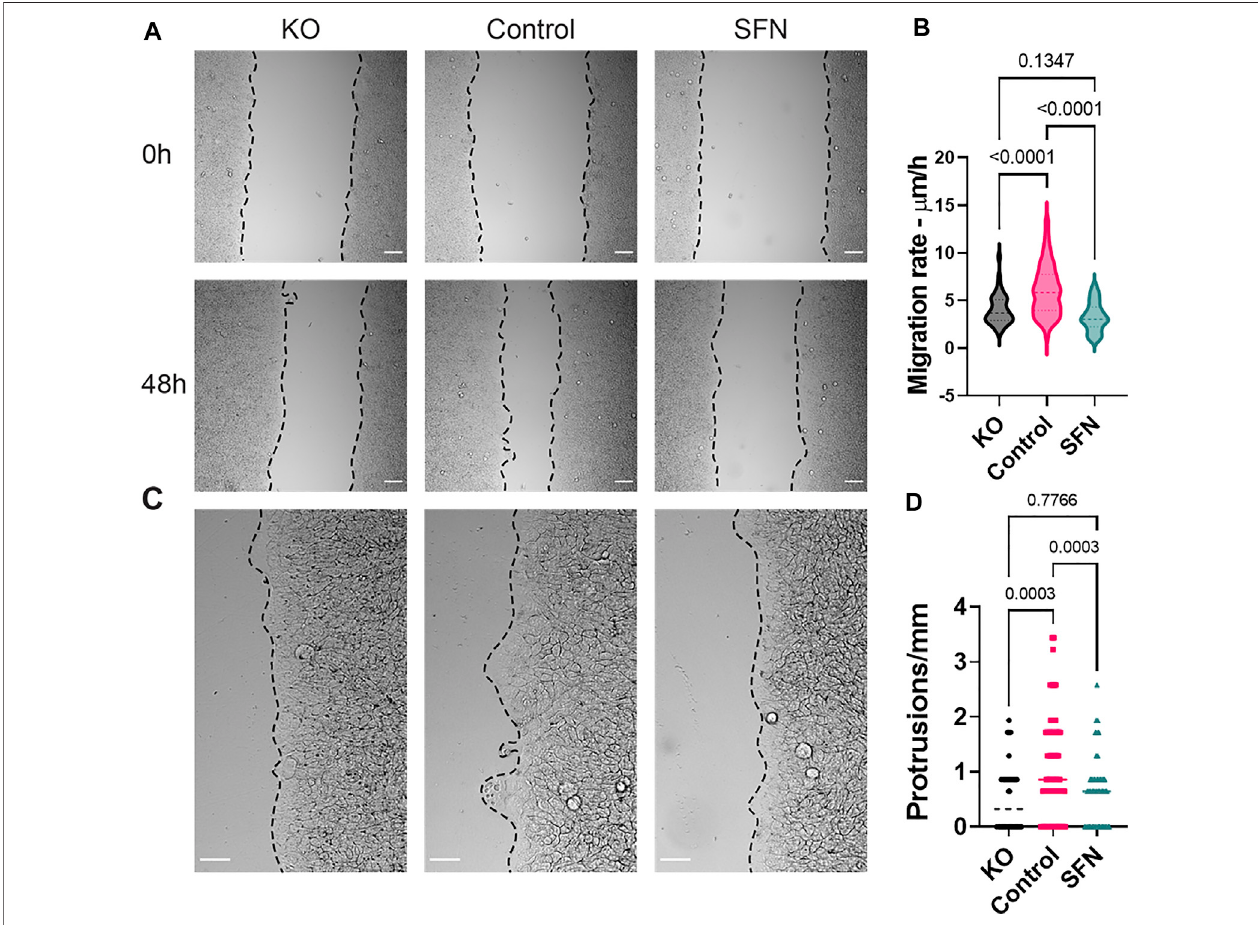
FIGURE 7 | Nrf2 modulations impair collective migration in a 2D model. (A) Bright- fi eld images of CRISPR/Cas9 NFE2L2-KO Pool RT4 cells (KO), RT4 cells (Control)andsulforaphanetreated(7.5 μ M,24 h)RT4cells(SFN)for0and48 hmigrationtimepoints.Scalebars,100 μ m. (B) ViolinplotofmigrationrateforKO,control, and SFN, respectively. One-way ANOVA with post-hoc Tukey test was used to compare across groups and the ROUT method was used to identify outliers (KO n = 44 leadingedges,Control n =91leadingedges,SFN n =78leadingedges). (C) Representativeimagesillustrating theformationofmigrationtips.Scalebars,100 μ m. (D) Violin plotofprotrusions/mmfor KO, control, and SFN, respectively. One-wayANOVA with post-hoc Tukey test wasused tocompare acrossgroups and theROUT methodwasused toidentify outliers(KO n = 43leadingedges, Control n = 110leading edges, SFN n =86leadingedges). Results arefrom four experiments performed across different